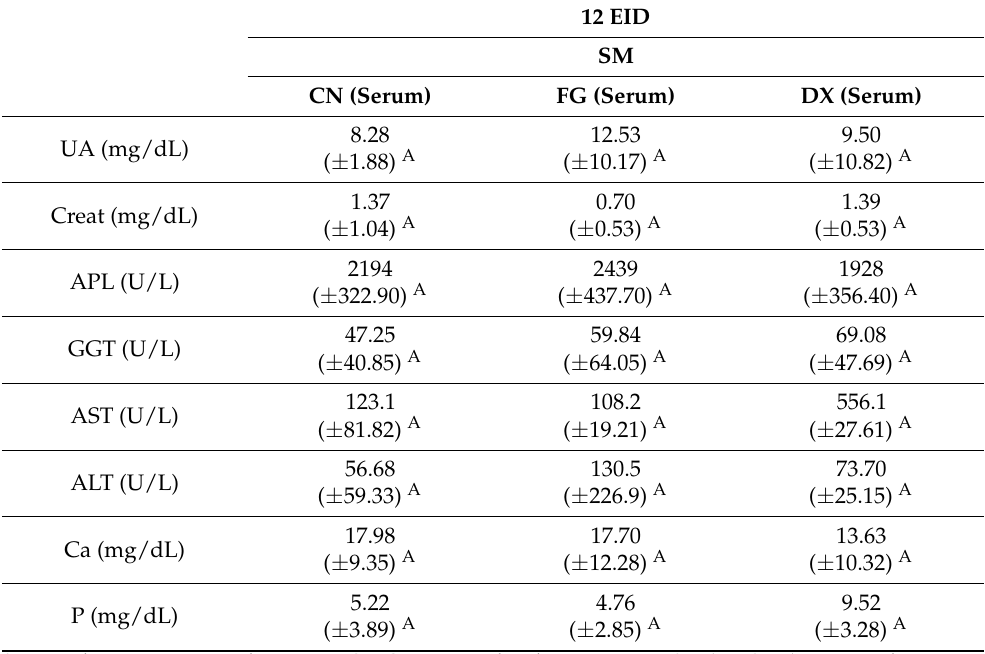
Table 9. Quantification of metabolites, minerals and enzymes in serum and AF in CE treated with FG and DX at 12 EID inoculated via